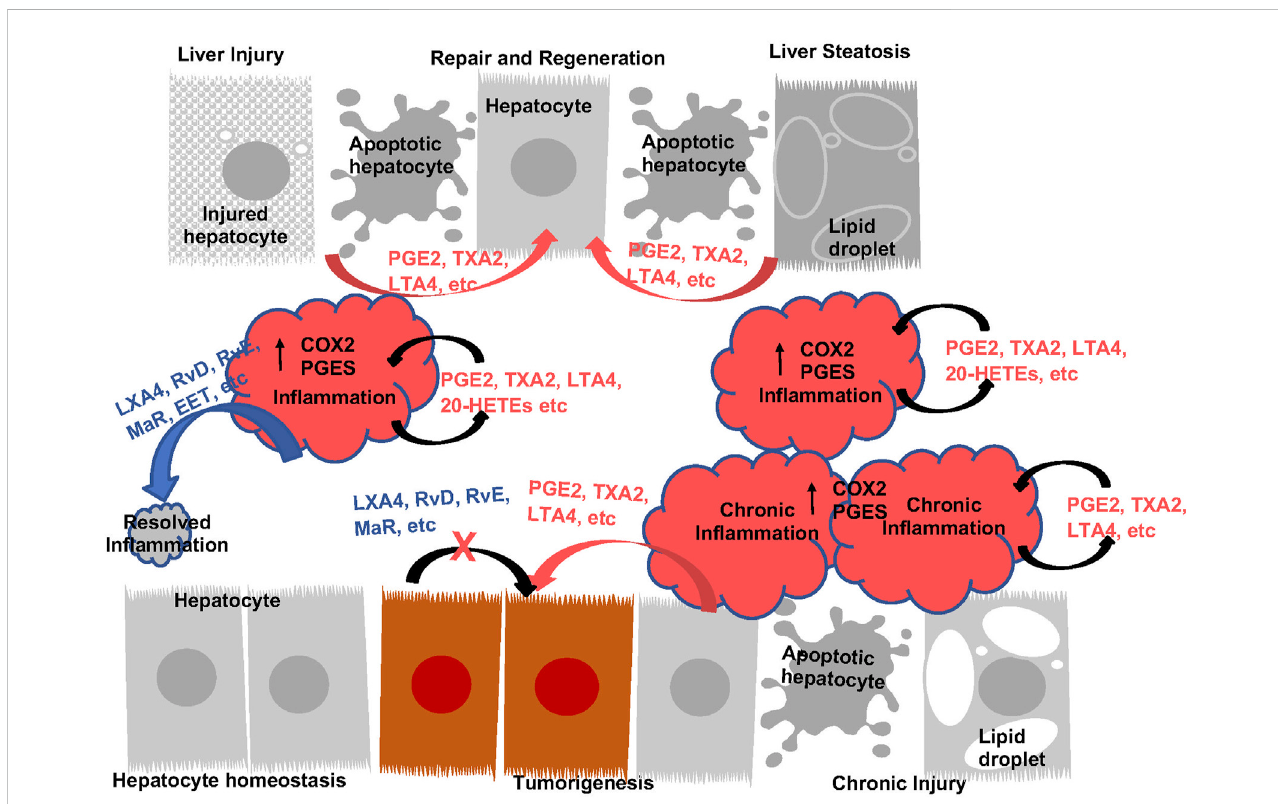
FIGURE 4 The Function of Eicosanoids and Oxylipins in Liver In fl ammation and Liver Disease Progression. During acute in fl ammatory response, prostanoids (PGE2 an TXA2, etc.) and leukotrienes (LTA4, etc.) are induced to induce in fl ammation. These eicosanoids plays roles to sustain in fl ammatory state as well as induce regeneration by acting as mitogenic signals for hepatocytes. During this process, induction of pro-resolving eicosanoids (LXA4, RvD, RvE, MaR, etc.) resolves in fl ammation, return the liver to homeostasis. With sustained injury, induction of eicosanoids sustains in fl ammation and establishes an environment for tumor growth. These eicosanoids also acts as mitogenic signals to promote tumor cells growth. The lack of pro-resolving lipids contributes to the chronic in fl ammatory state. Addition of pro-resolving eicosanoids also directly attenuate tumor cell